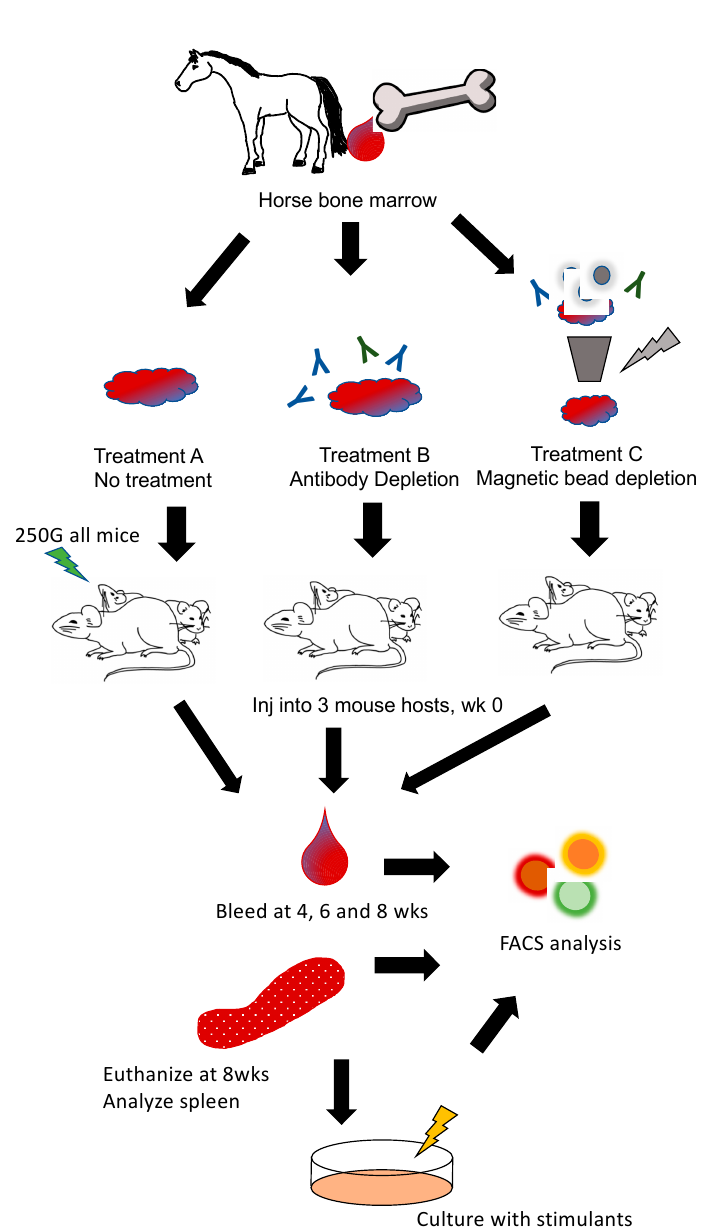
Figure 2. Diagram of experimental design for equine bone marrow cell transfer into NSG mouse recipients. On day 0, equine bone marrow was harvested from two donor horses. Bone marrow aliquots were either left untreated (treatment A), incubated with anti-equine T cell antibodies to deplete T cells (treatment B), or underwent magnetic bead depletion of equine T cells (treatment C). Cells (5–10 × 10 6 via IP injection) were then transferred to 3 recipient mouse hosts. Peripheral blood samples were analyzed on day 28, day 42, and day 56. On day 56, mice were sacrificed and splenic cellular analysis was then performed as well as cell culture with LPS, ConA, and PWM stimulation. Cultured cells were analyzed on day 58 via flow cytometry. Inj = inject, Wks = weeks, FACS = fluorescence activated cell sorting or flow cytomtery.